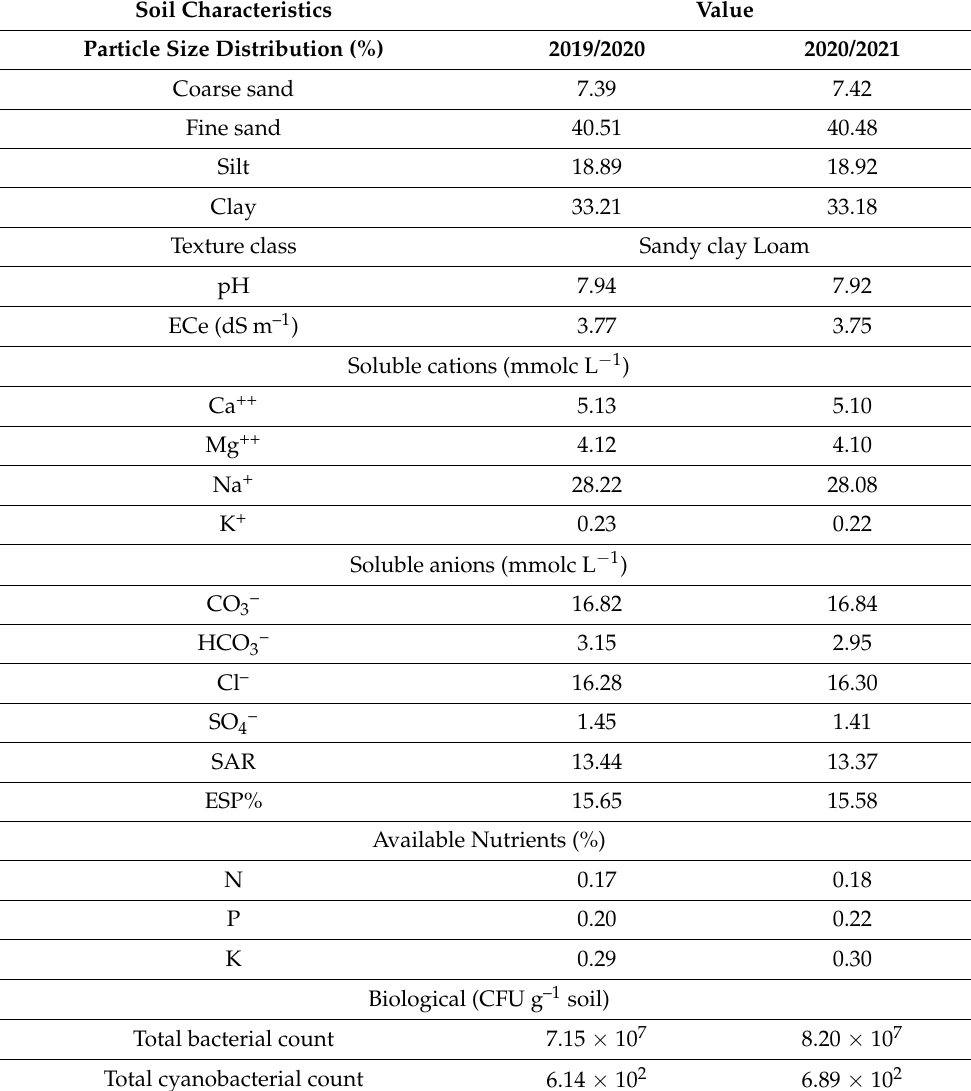
Table 1. The physiochemical and biological properties of the experimental soil before